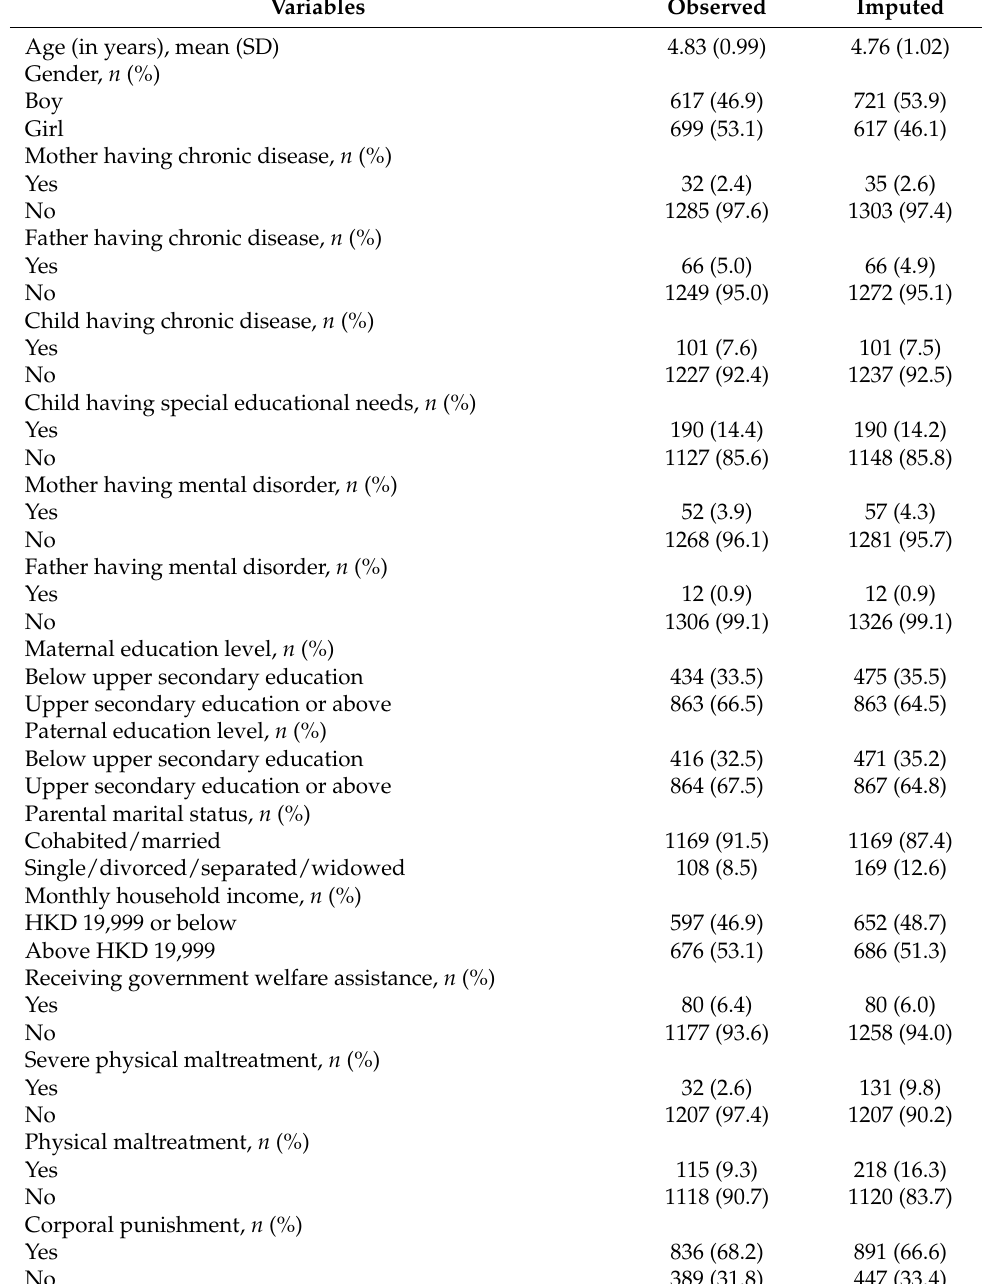
Table 1. Description of the study sample ( n = 1338) and comparison of observed and imputed data. Variables